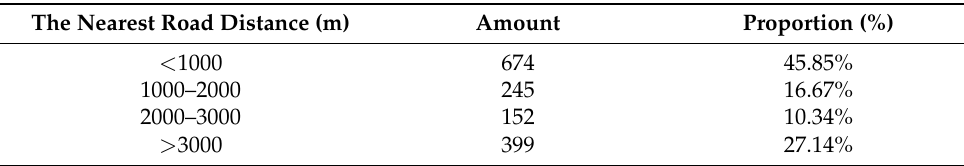
Table 6. Analysis of road